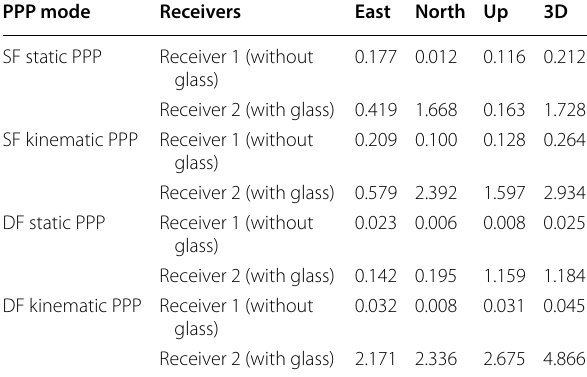
Table 7 RMS statistics of GPS/GLONASS single-frequency (SF) and dual-frequency (DF) static and kinematic PPP positioning errors (unit: m)